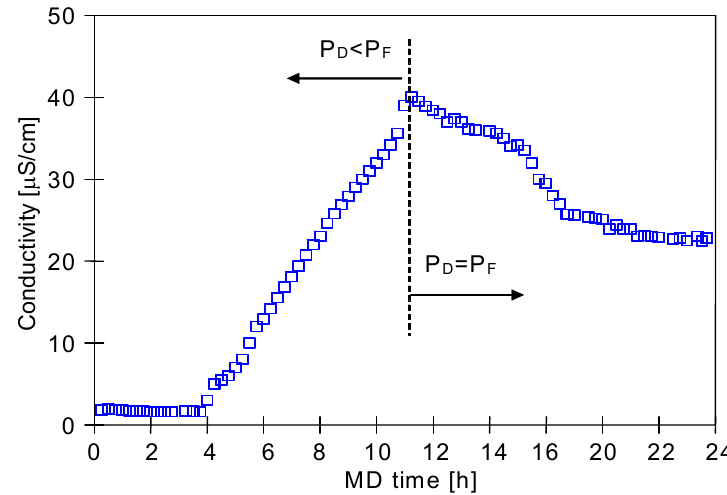
Figure 7. Changes in the distillate conductivity during the MD process. Feed: Baltic Sea water + oil (105 mg/L) + SDS (2.5 mg/L). Dashed line—the moment of equalizing the hydraulic pressure on the feed (P F ) and distillate (P D ) sides. Module CMD.